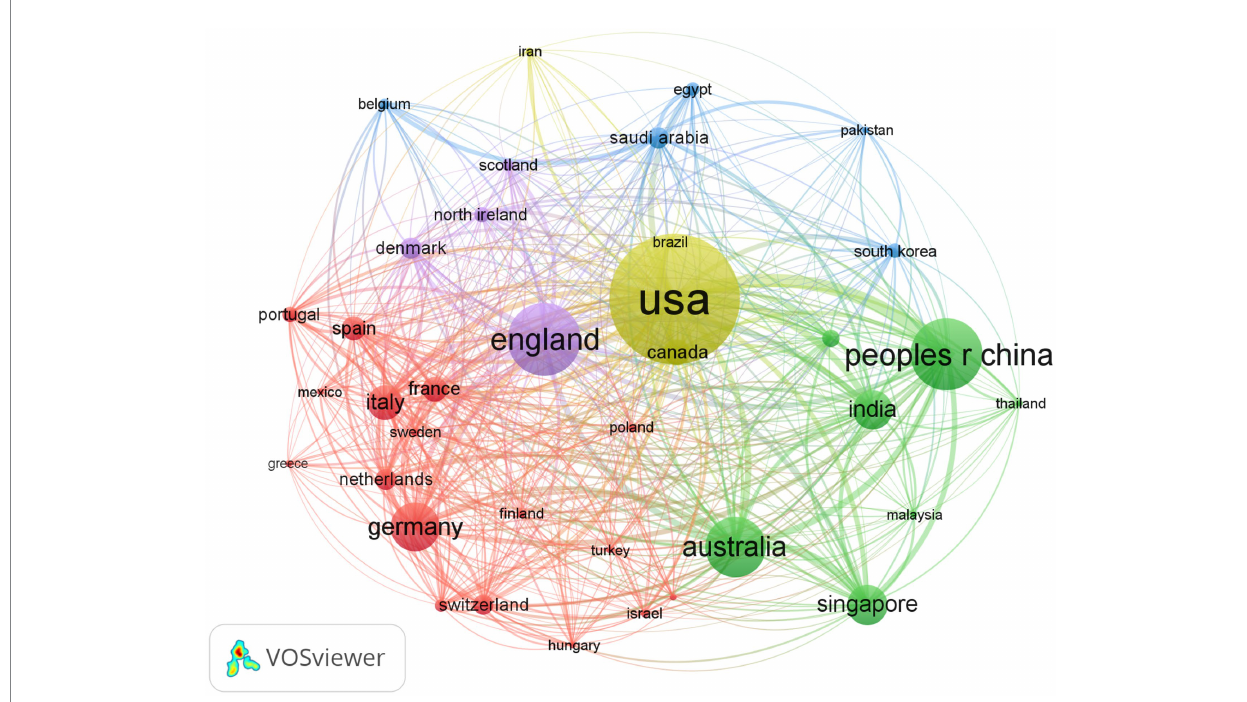
FIGURE 2 Bibliometric analysis of the countries’ cooperations on DR. The node represents a country, the bigger the node the total link strength is stronger. The lines represent cooperation, and the thickness of the lines represents the closeness of the cooperation.